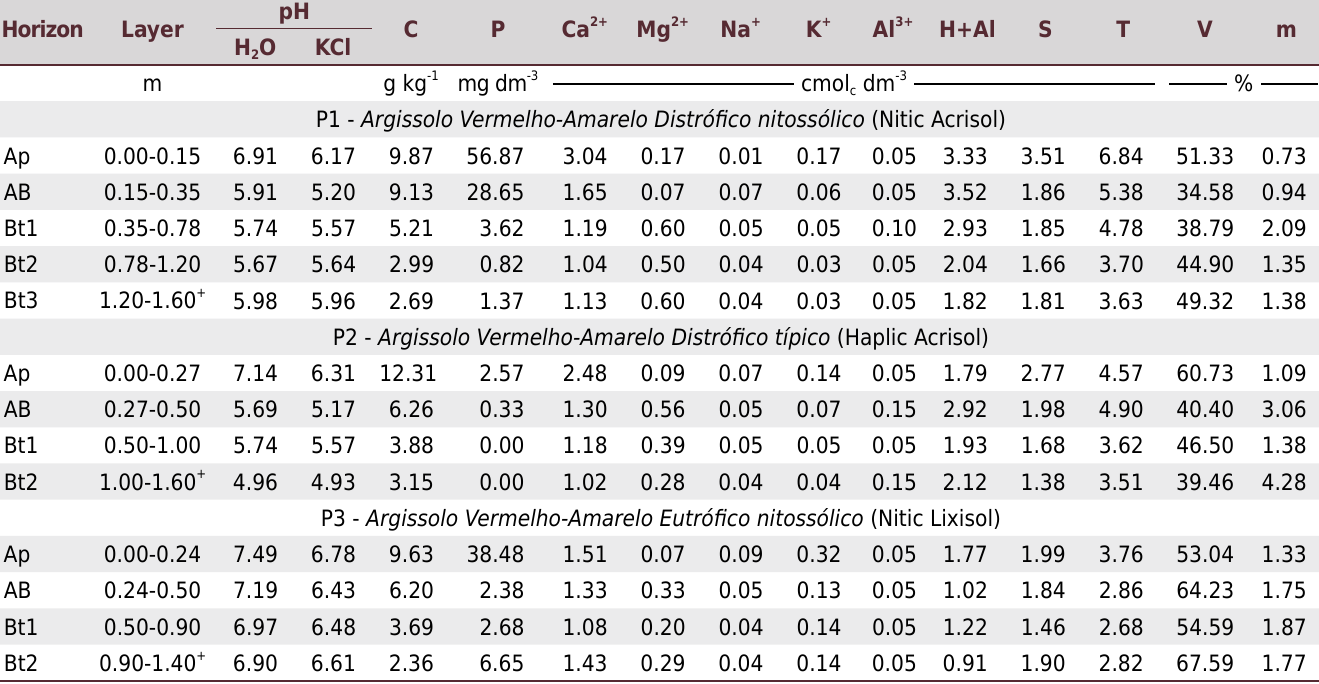
Table 3. Chemical properties of soils in a topographic sequence, São Vicente Férrer, Pernambuco, Brazil Horizon Layer